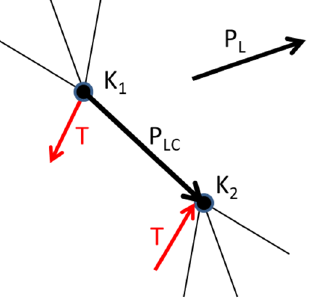
Figure 6. Power transfer distribution factor (PTDF) analysis approach.